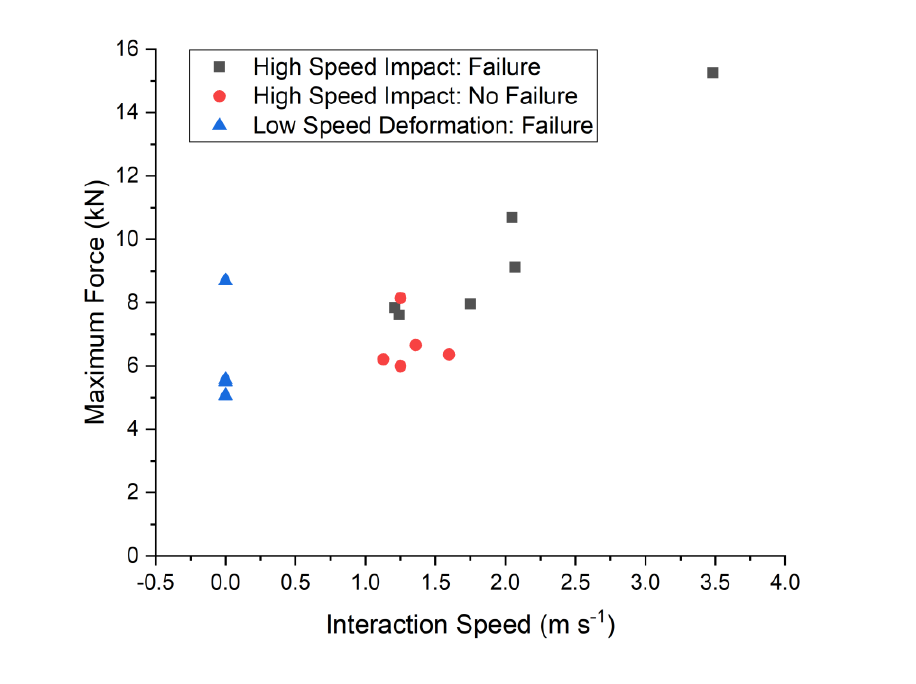
Fig. 3. Maximum force achieved for a number of cutters for both high and low deformation